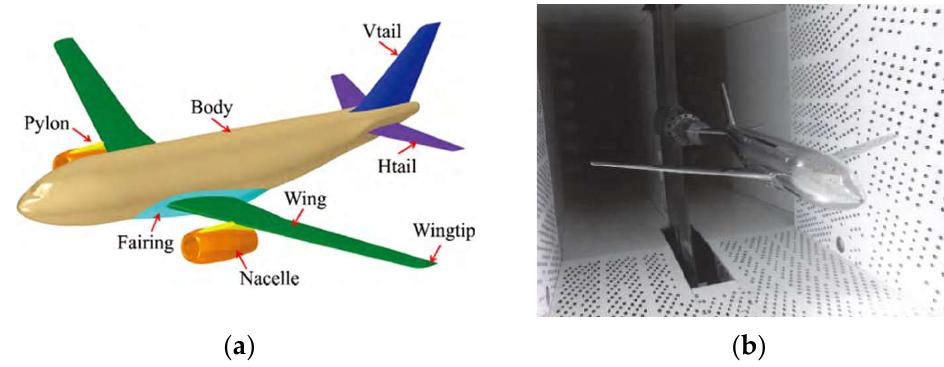
Figure 1. The complete configuration of CHN-T1 ( a ) and the model tested in 2.4 m wind tunnel ( b ). Reprinted with permission from Ref. [18], 2019, Li Q.